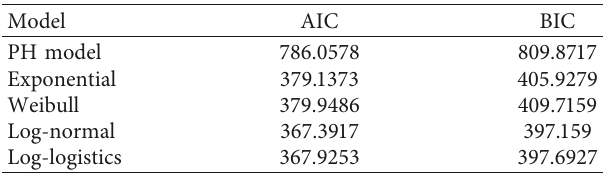
Table 8: Comparison of the PH model and the AFT models using AIC